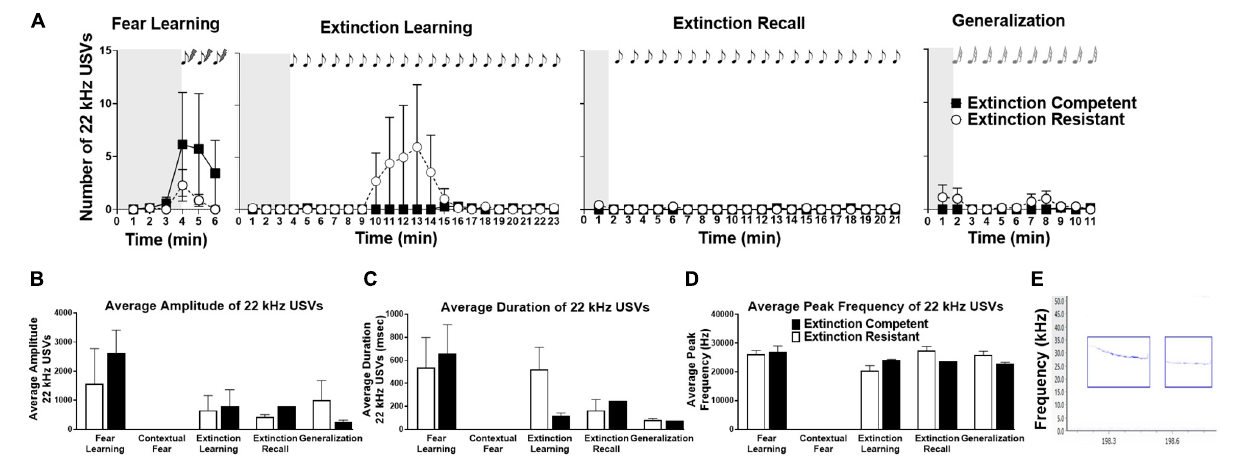
FIGURE 3 | Female rats emitted very few 22 kHz ultrasonic vocalizations (USVs) during fear learning, extinction learning, extinction recall, and generalization trials, and no 22 kHz USVs were seen during contextual fear recall (not shown). In panel (A) , the number of 22 kHz USVs in extinction competent (filled squares, EC) and extinction resistant (open circles, ER) rats in each 1-min time bin is shown. Shaded areas represent the unconditioned vocalizations before tone–shock pairings (fear learning) or the first conditioned/novel tone (extinction learning, extinction recall, and generalization). Very few females showed 22 kHz vocalizations, and most of these were during fear learning (tone–shock pairings). EC and ER rats did not differ significantly in the number of 22 kHz calls during any of the trials. Panels (B–D) show that EC and ER phenotypes did not show any differences in the acoustic parameters of 22 kHz USVs, including the average amplitude of each call (B) , average duration of each call (C) , or average peak frequency of the calls (D) across all trials. Panel (E) shows a representative spectrogram of 22 kHz USVs; the blue boxes identify the detected 22 kHz USVs using UltraVox software. Points and bars represent mean ± SEM, with N = 7 ER and N = 7 EC rats per group.